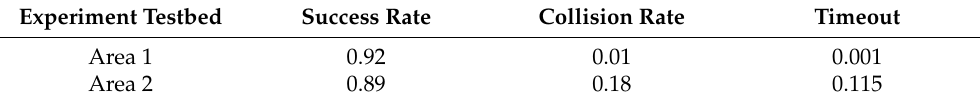
Table 4. Quantitative results including the success rate and collision rate for two